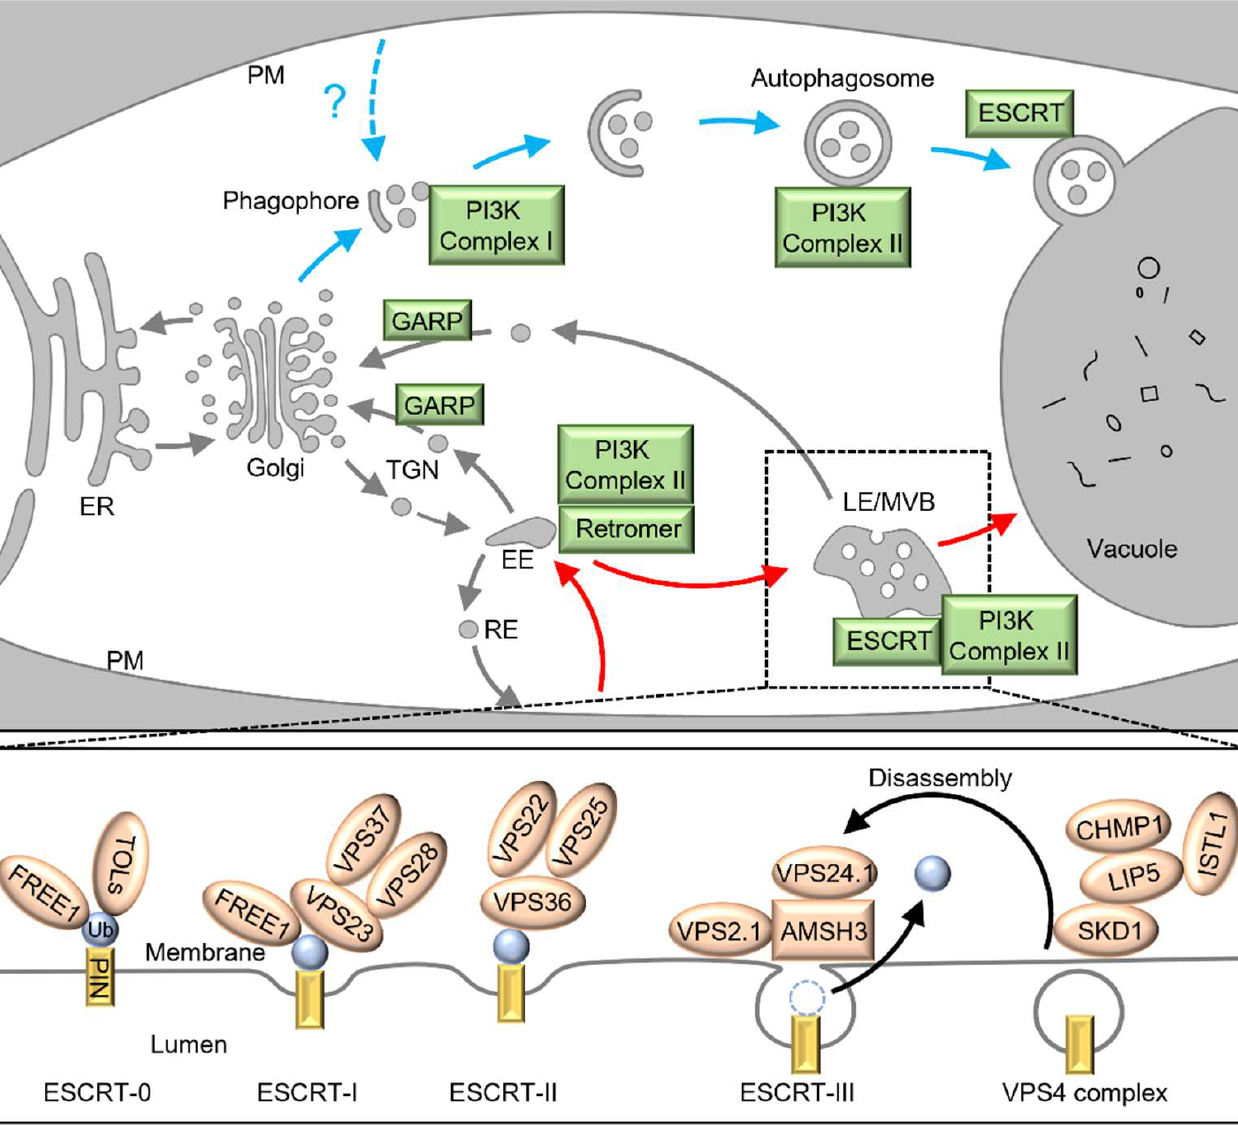
Figure 1. An illustration of PIN degradation in plants. Ubiquitinated PINs are proposed to be endo- cytosed from the PM for degradation via endosome-mediated vacuolar targeting (red arrows). The ESCRT mediates the sorting of PINs into the intraluminal vesicles of endosomes as highlighted in MVBs and the detailed process is shown in the lower panel. CHMP1 and ISTL1 are two subunits of the ESCRT-III, each influencing activity of SKD1 via interaction with LIP5. Recent work also sug- gests the involvement of autophagy in PIN degradation (blue arrows), although the explicit process is largely unknown and how PIN-residing membrane structures are integrated into the autophagic pathway remains in mystery. The ESCRT is also required for fusion of autophagosomes to the vac- uole. ER, endoplasmic reticulum; TGN, trans-Golgi network; EE, early endosome; PM, plasma